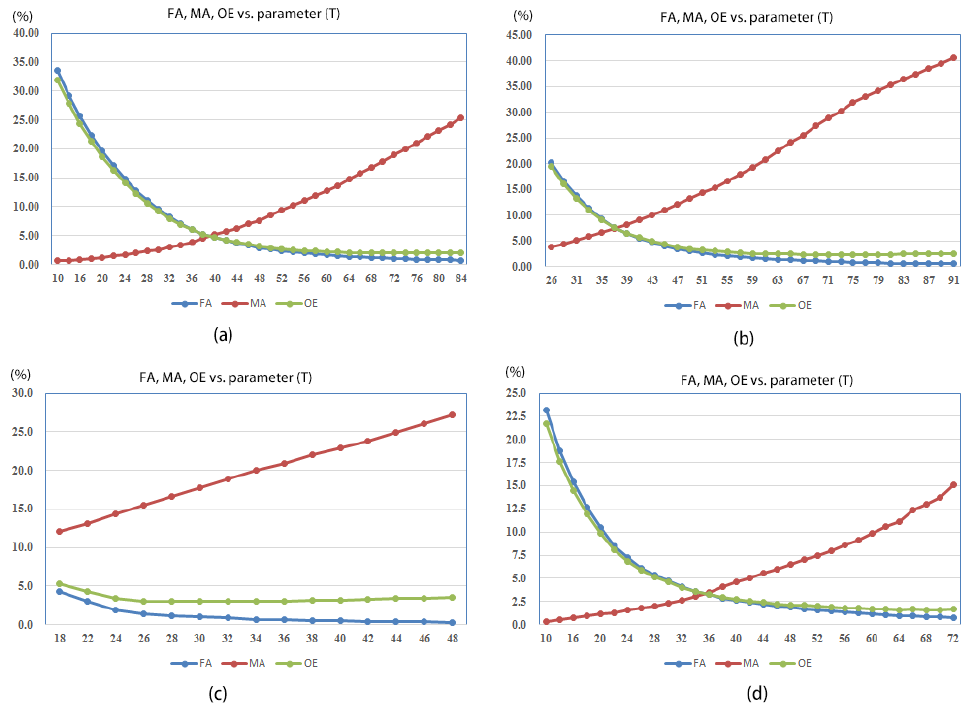
Figure 17. Relationship between detection accuracy and parameter (T) setting of the proposed framework in each experiment: ( a ) Experiment 1; ( b ) Experiment 2; ( c ) Experiment 3; and ( d ) Experiment 4.